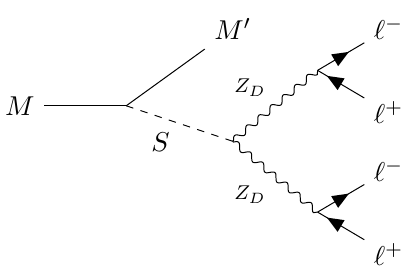
Figure 3 . Representative diagram for the process we consider in our analysis of a meson M decaying to a SM state M 0 and a dark Higgs S , that subsequently decays to a pair of dark photons. See text for more